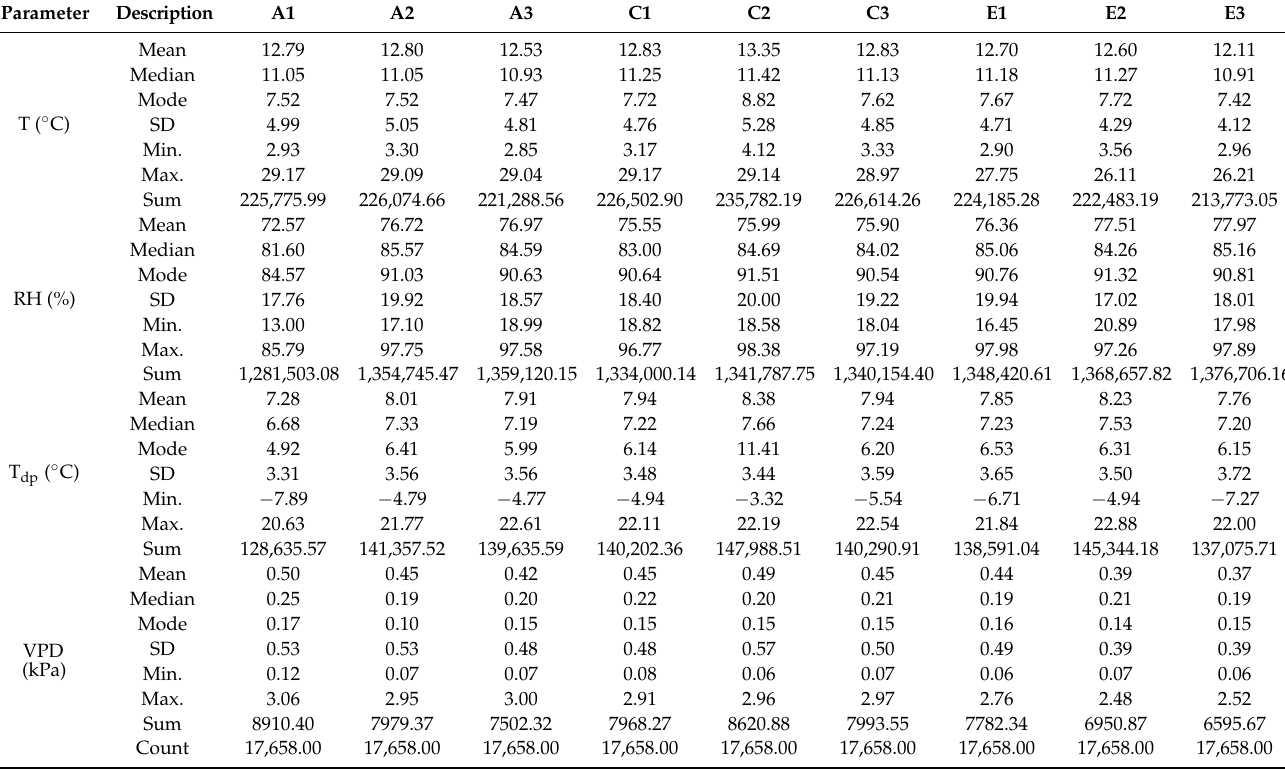
Table 1. Descriptive statistics of T, RH, T dp , and VPD distributions in SLG. SD: standard deviation; Min.: minimum; Max.: maximum; RH: relative humidity; T dp : dew point temperature; VPD: vapor pressure deficit; SLG: single-layered greenhouse.